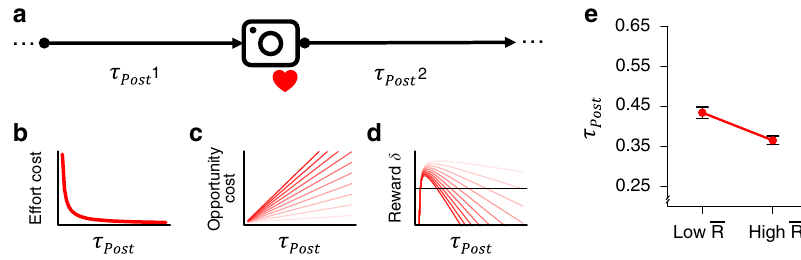
Fig. 1 Schematic illustration of the computational hypothesis. a The (cid:1) RL model describes how τ Post , the latency to the next social media post (denoted by the “ camera ” icon), is shaped by social rewards. Each post is followed by social reward (denoted by the “ heart ” symbol), which varies in number. The model adjusts the response policy, or threshold, which determines τ Post , to maximize the average net rate of reward. b The (cid:1) RL model posits an effort cost to responding (e.g., taking pictures, uploading), which decreases as a function of τ Post . The effort cost term penalizes posting in quick succession, because high effort reduces the average reward rate. c The opportunity cost of time increases as a function of the average reward rate (cid:1) R . The gradient of red lines indicates increasing values of (cid:1) R (darker colors represent higher values), and thereby higher opportunity cost. d The optimal value of τ Post , which maximizes the net reward δ , varies as function of (cid:1) R (darker colors represent higher values). The δ is used to update average reward rate (cid:1) R. Note that the optimum, indicated by the peak of the function, moves to shorter response latencies when (cid:1) R is higher because the opportunity cost of time increases with (cid:1) R. The horizontal line denotes 0. The fi gure assumes a constant effort cost C . e Simulated model predictions . The (cid:1) RL model predicts that τ Post , the latency between successive social media posts, will be shorter with high compared to low average reward rate, (cid:1) R. The simulation involved N = 1000 independent synthetic individuals. The prediction is presented as estimated mean ± 99% CI from mixed-effects